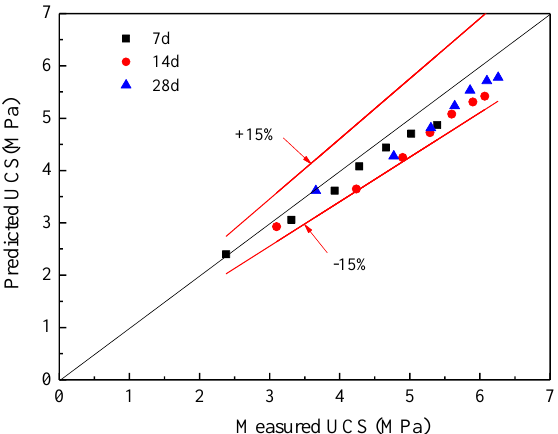
Figure 9. Correlation between the predicted UCS and measured UCS.